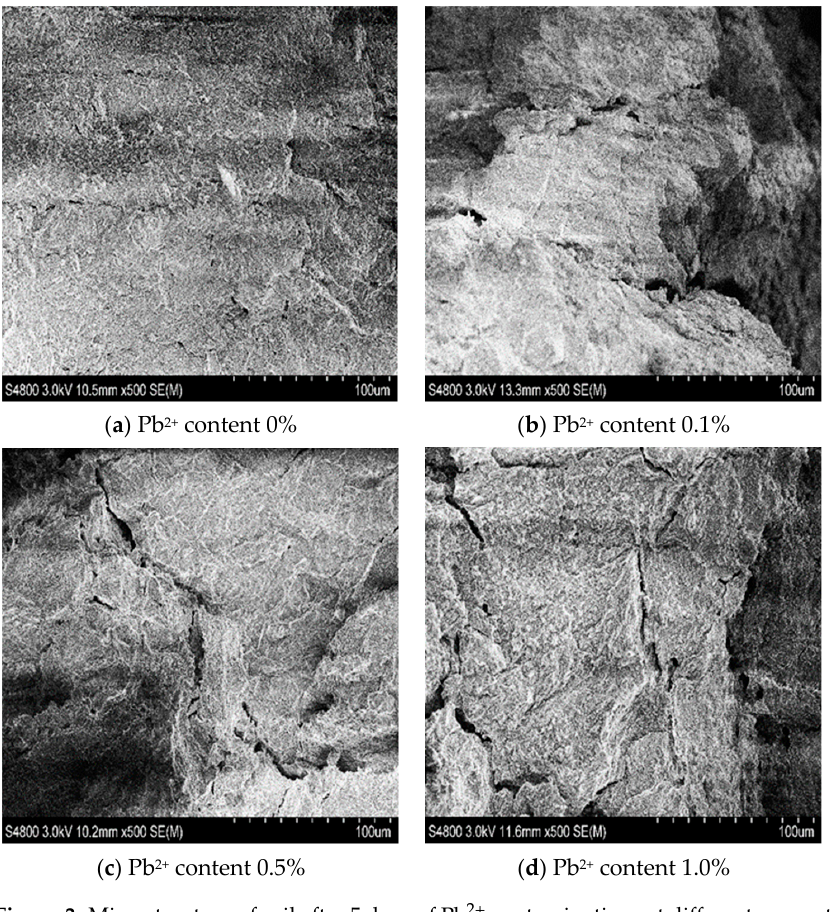
Figure 3. Microstructure of soil after 5 days of Pb 2+ contaminations at different concentrations (500×).